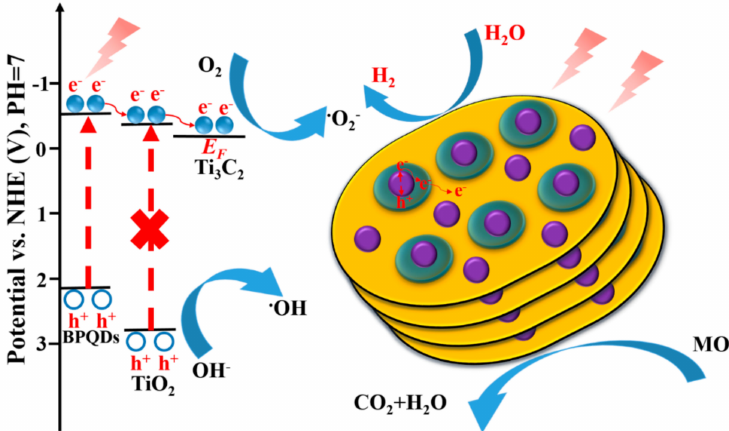
Figure 10. Schematic illustration of photocatalytic reaction of BPQDs / Ti 3 C 2 @TiO 2 composites under visible